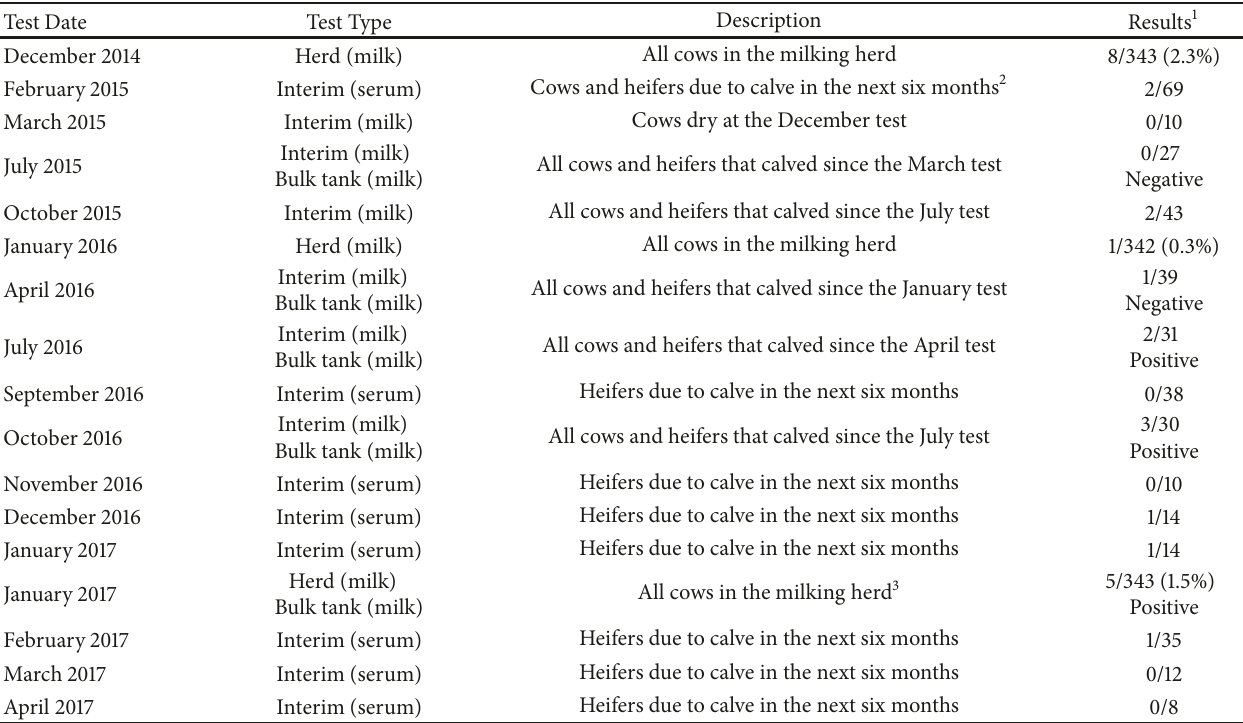
Table 3: Bovine leukemia virus (BLV) antibody testing schedule and results for Herd